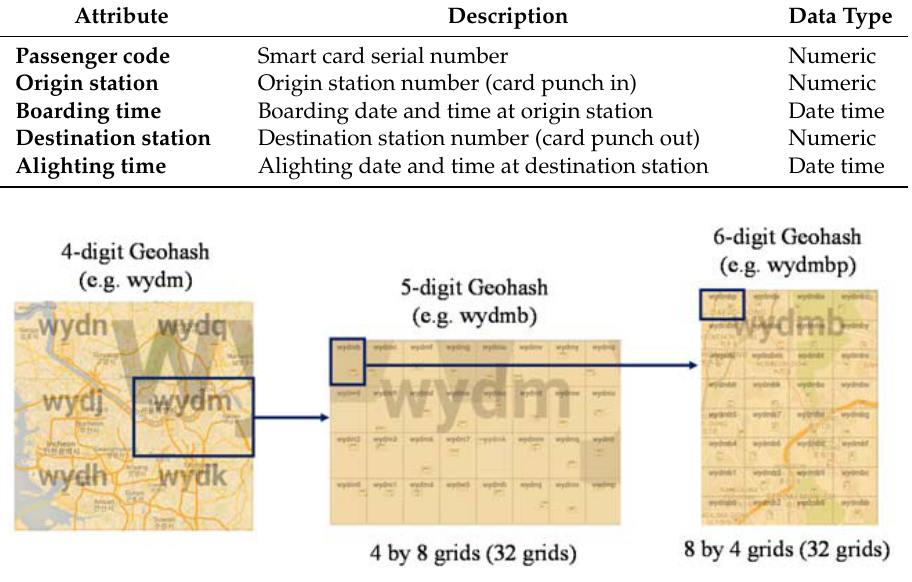
Figure 1. Hierarchical structure of the Geohash system for global geo-coding.